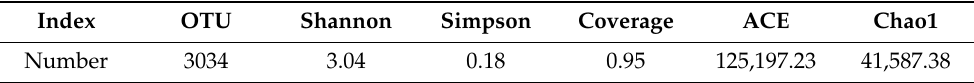
Table 3. Alpha diversity index of microorganisms.